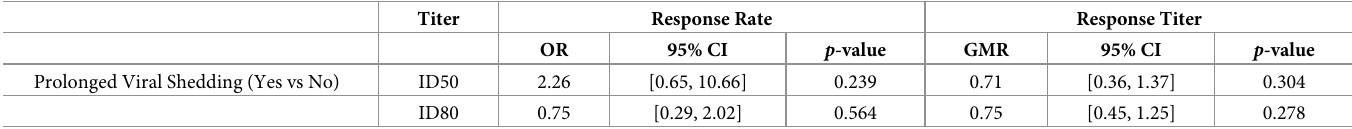
Table 4. Comparison of nAb responses between participants with ( n = 33) and without ( n = 232) prolonged viral shedding after adjusting for COVID-19 severity, demographics (age, sex assigned at birth, BMI, and region), and days since SARS-CoV-2 diagnosis among symptomatic outpatients and hospitalized individuals in Americas